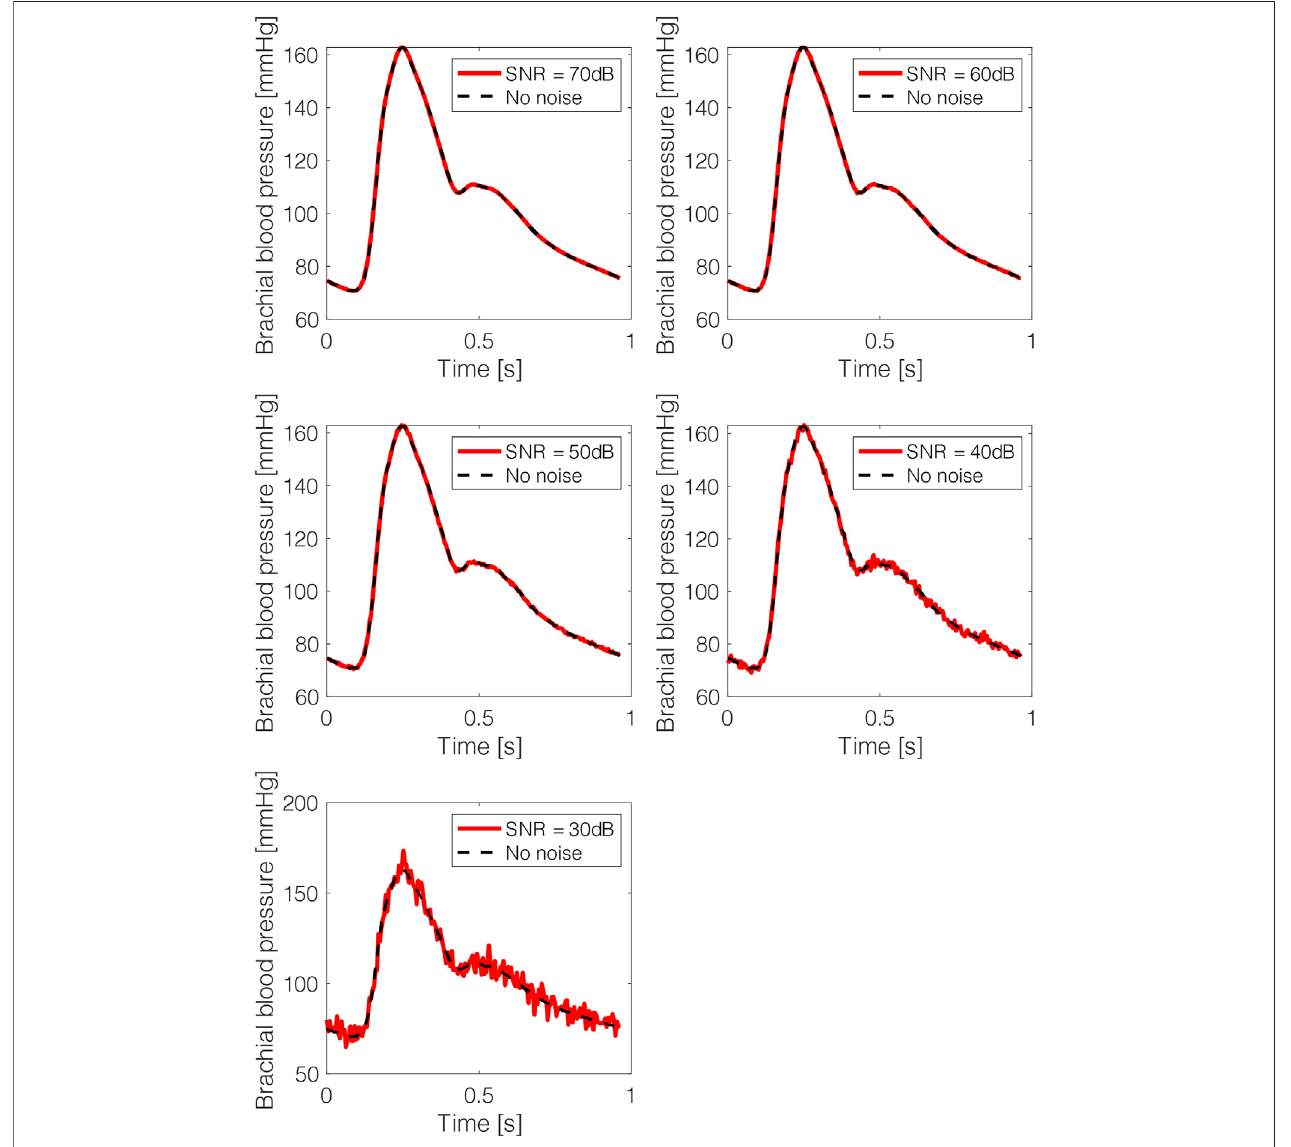
FIGURE 3 | Brachial blood pressure waves after adding arti fi cial noise. The noisy data are presented in red solid lines and the original noise-free data in black dashed lines.